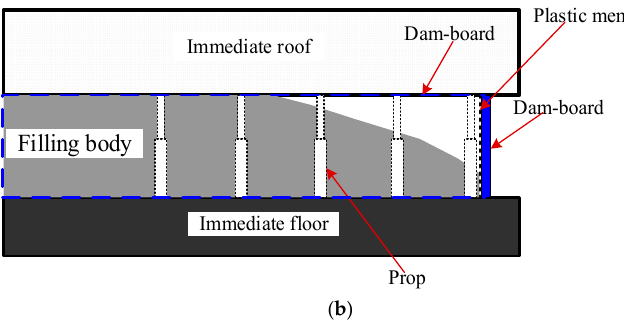
Figure 15. Filling retained roadway along gob of No. 41101 main transportation roadway: ( a ) plan view and ( b ) cross-section A-A.